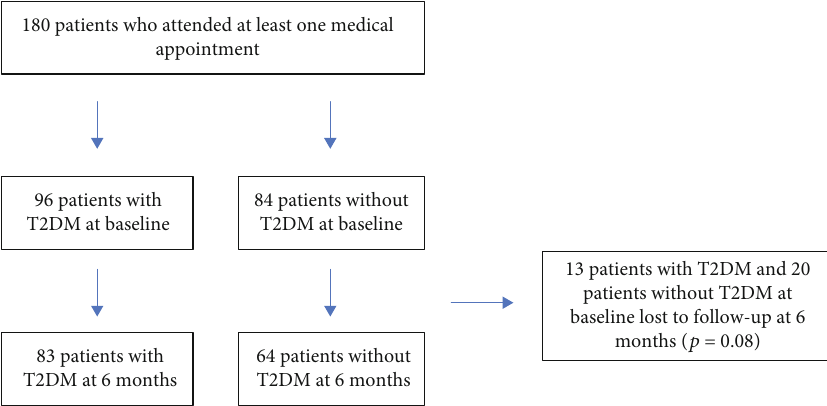
Figure 1: Entry of patients at baseline and loss to follow-up at 6 months, by T2DM